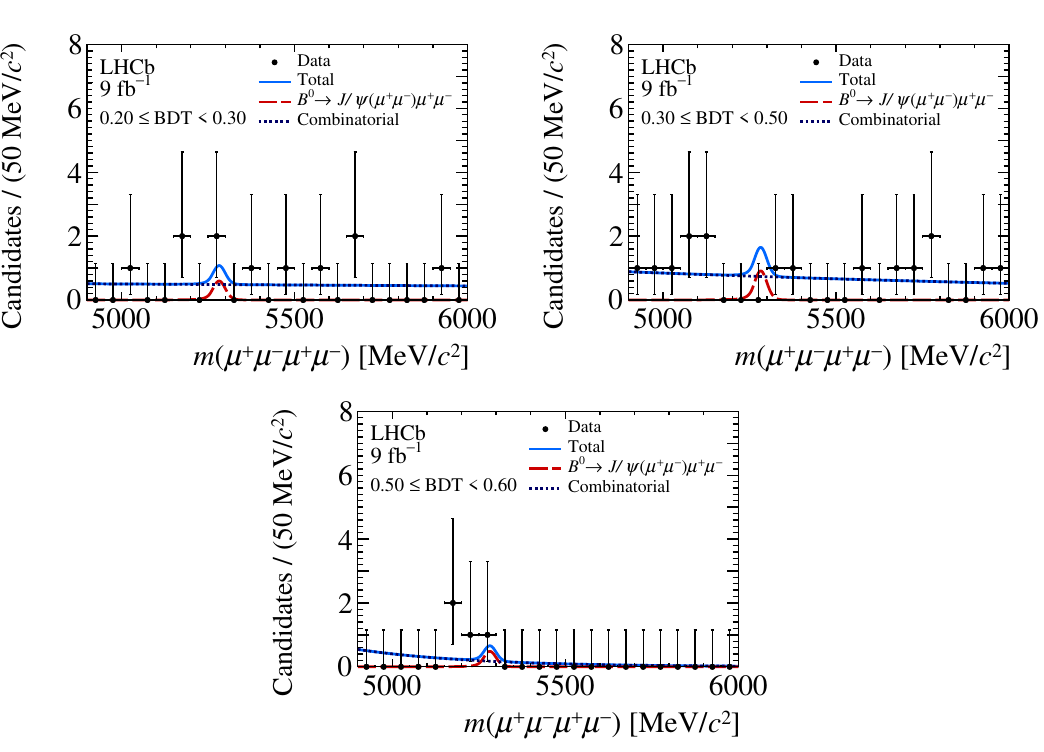
Figure 11 . Distribution of the µ + µ − µ + µ − invariant mass of candidates passing the B 0 → J/ψ ( µ + µ − ) µ + µ − selection in (top left) the lowest BDT interval, (top right) the second ( s ) lowest BDT interval and (bottom) the second highest BDT interval, with the fit models used to determine the branching fraction of B 0 → J/ψ ( µ + µ − ) µ + µ −